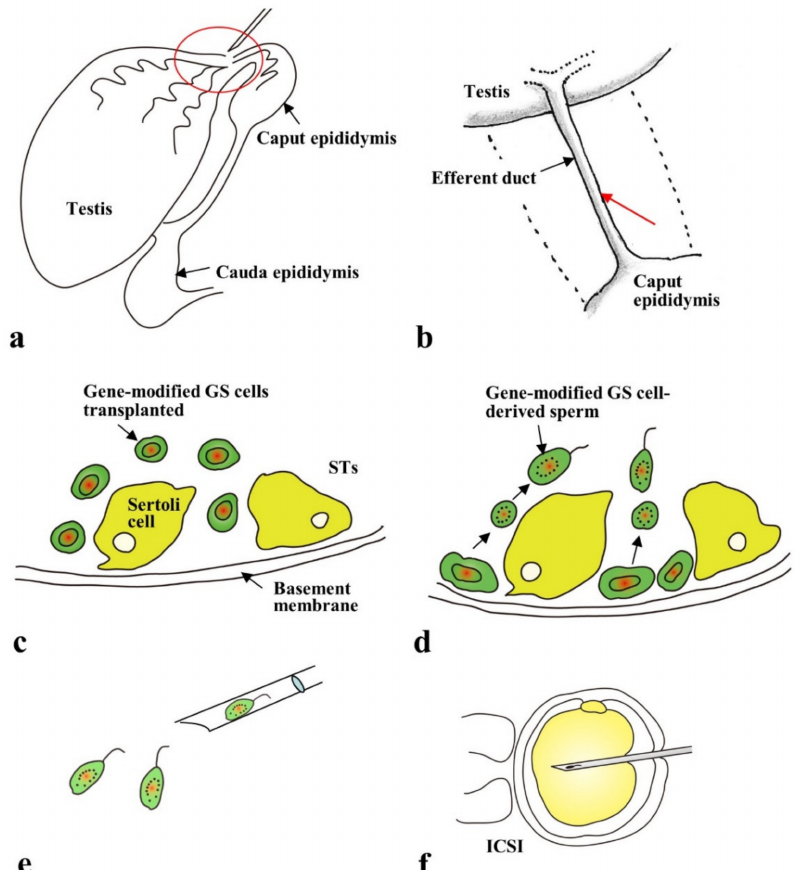
Figure 2. Transplantation of gene-engineered germline stem (GS) cells into the lumen of seminiferous tubules (STs) of a sterile testis and subsequent intracytoplasmic sperm injection (ICSI) of the GS cell-derived sperm for production of genetically modified mice, schematically shown: ( a ) Transplantation of the gene-engineered GS cells via rete testis inside the STs of a testis that has been pretreated with busulfan to eliminate endogenous spermatogonial stem cells. The portion surrounded by a red circle is shown in b for more detailed explanation. ( b ) Transplantation of cells by insertion of a glass micropipette into an e ff erent duct to an orientation shown by the red arrow. ( c ) Gene-engineered GS cells just after introduction into the lumen of the STs. ( d ) Di ff erentiation of gene-engineered GS cells. The transplanted gene-engineered GS cells move from the luminal compartment to the basement membrane where spermatogonia are located. Then, they survive and proliferate, while also producing immature sperm. ( e ) Gene-engineered GS cell-derived immature sperm isolated from the transplanted testis, which will be used for ICSI. ( f ) ICSI using GS-derived immature sperm. The ICSI-treated oocytes are then allowed to develop further through embryo transfer to the oviducts of pseudo-pregnant females to generate the gene-engineered